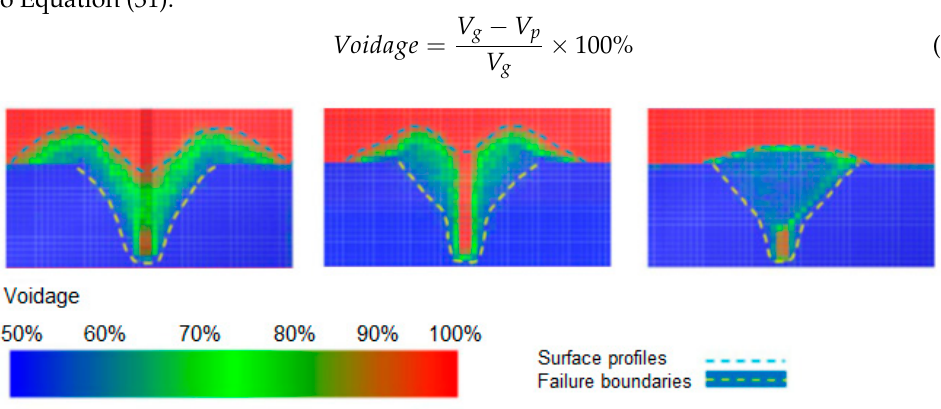
Figure 15. Furrow profiles created using voidage grid bins in EDEM 2.7 TM . Adapted from Barr [49].